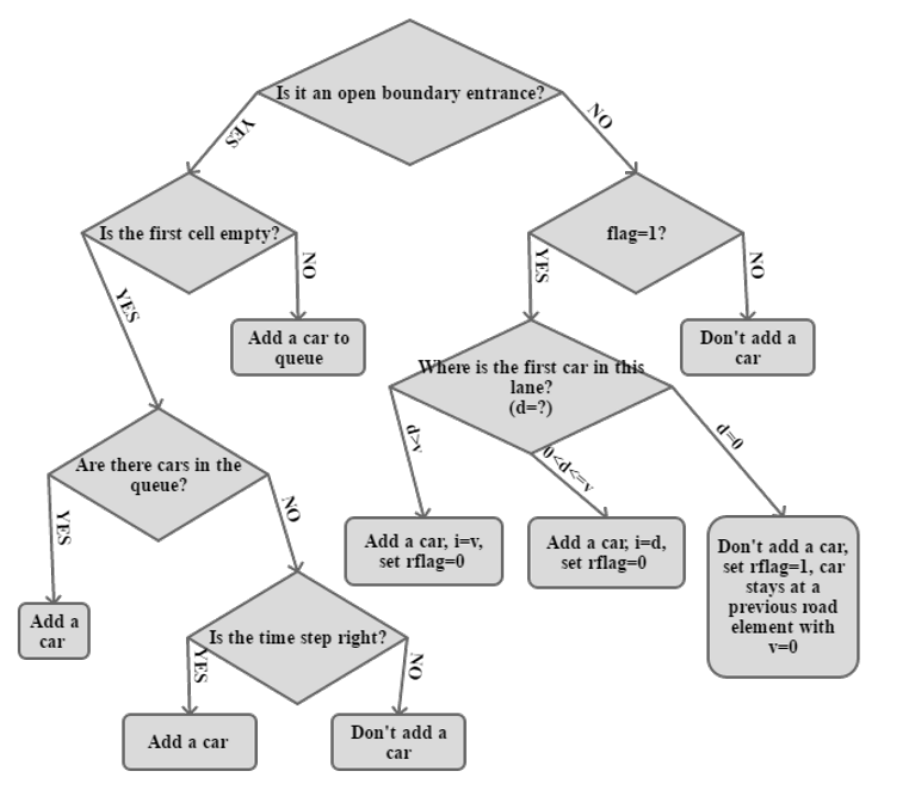
Fig. 6. Block-scheme of the algorithm of adding a car to a road